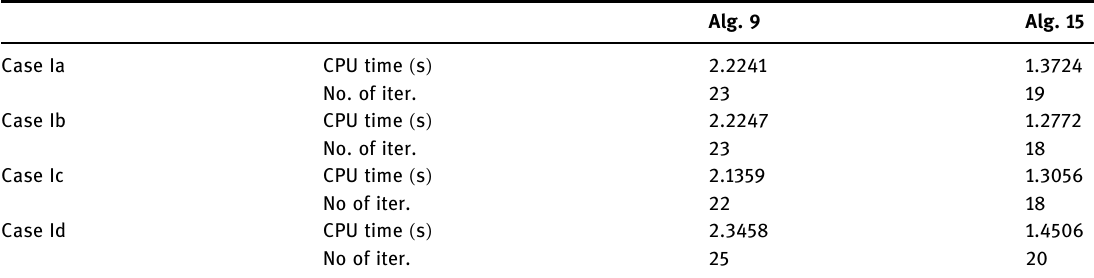
Table 2: Numerical results for Example